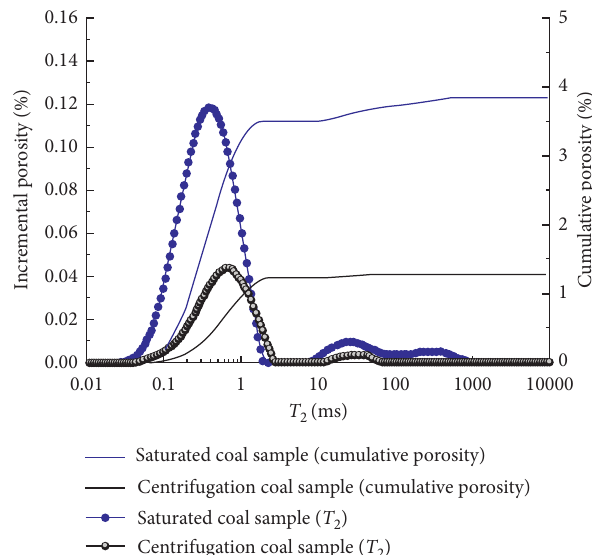
Figure 8: T 2 distribution and porosity distribution of vertical bedding at saturated and centrifugal